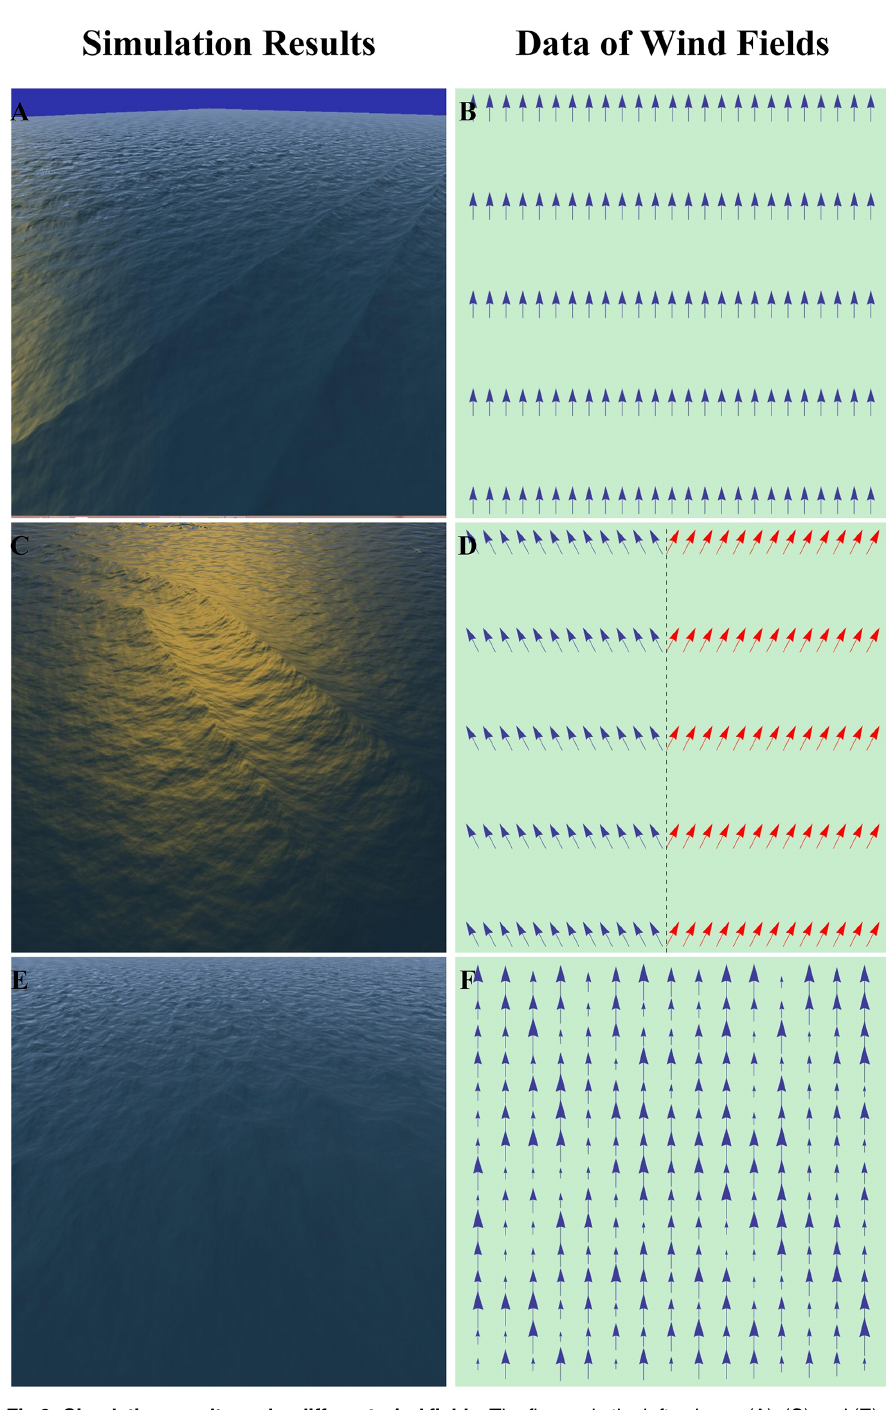
Fig 9. Simulation results under different wind fields. The figures in the left column, (A), (C) and (E), are sample frames captured from the simulation results under the wind conditions of (B), (D) and (F), respectively, in the right